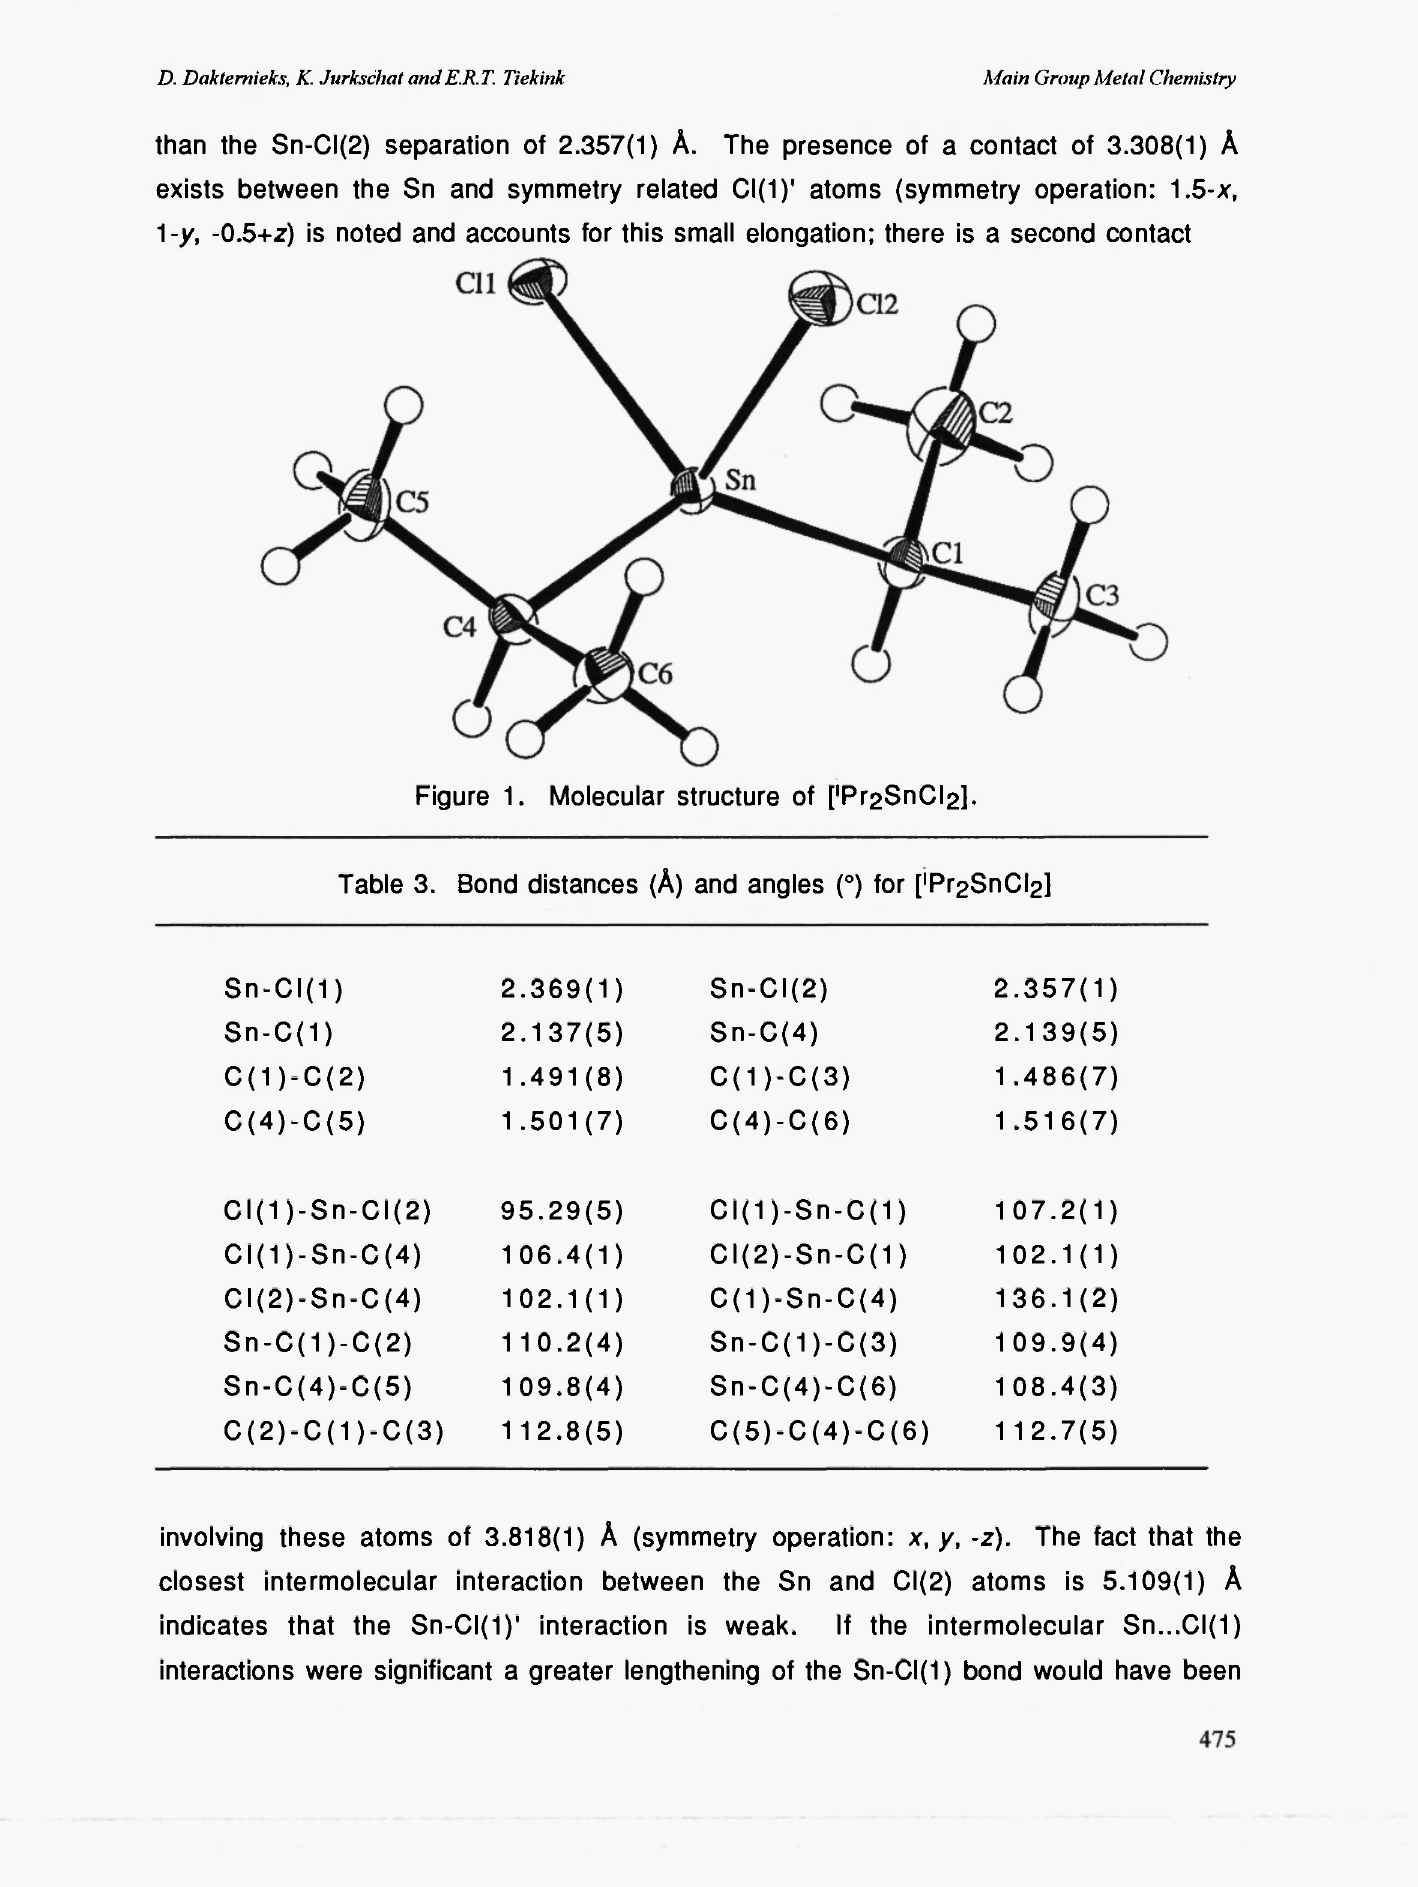
Figure 1. Molecular structure of ['Pr2SnCl2].